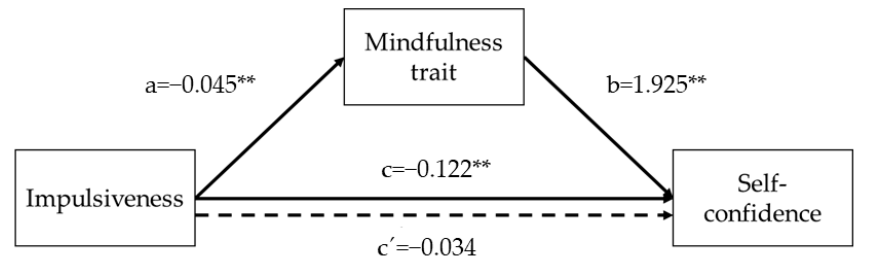
Figure 3. Graphical representation of the mediation effect of mindfulness in the association between impulsiveness and self-confidence. The numerical values correspond to the unstandardized regression coefficients. Dashed line represents the mediated association. ** p < 0.01.